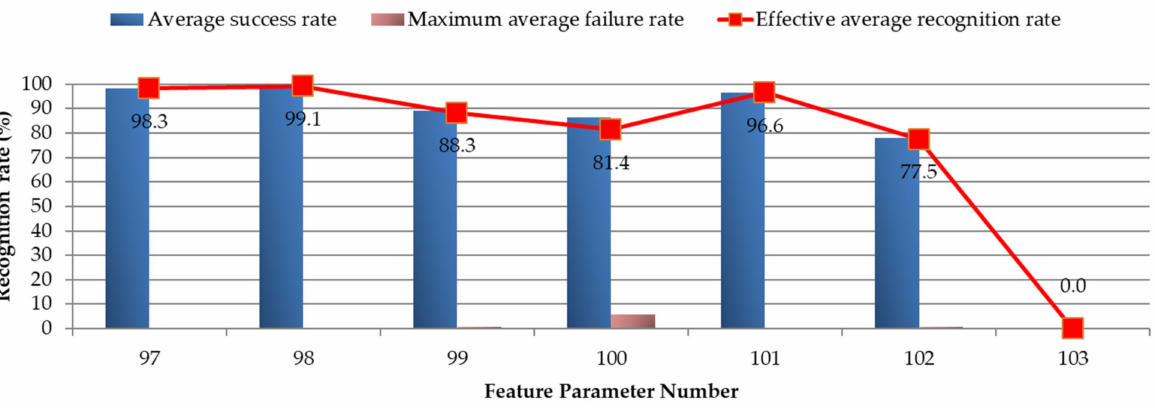
Figure 38. GIS-3 partial discharge characteristic parameters: identification rate of the discharge intensity